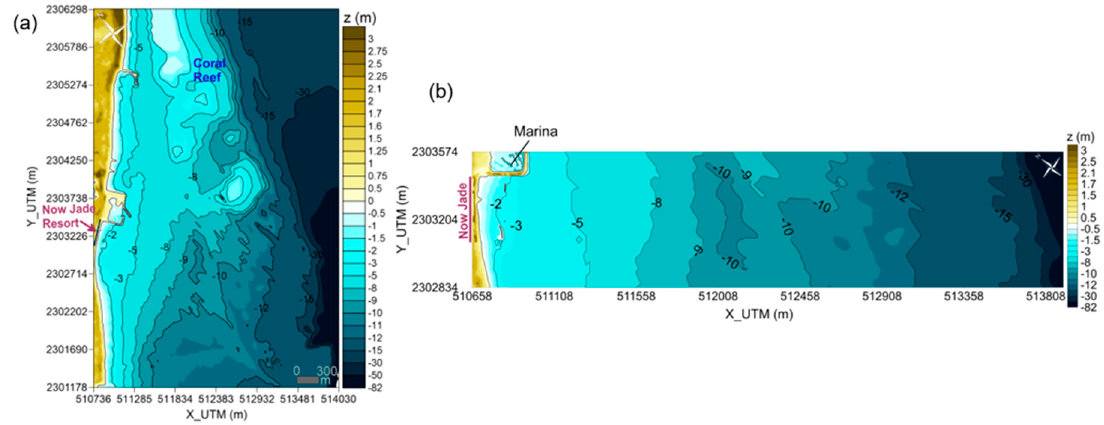
Figure 3. Bathymetric data within the domain of the simulation grid meshes for XBeach model: ( a ) general mesh; ( b ) detailed mesh.